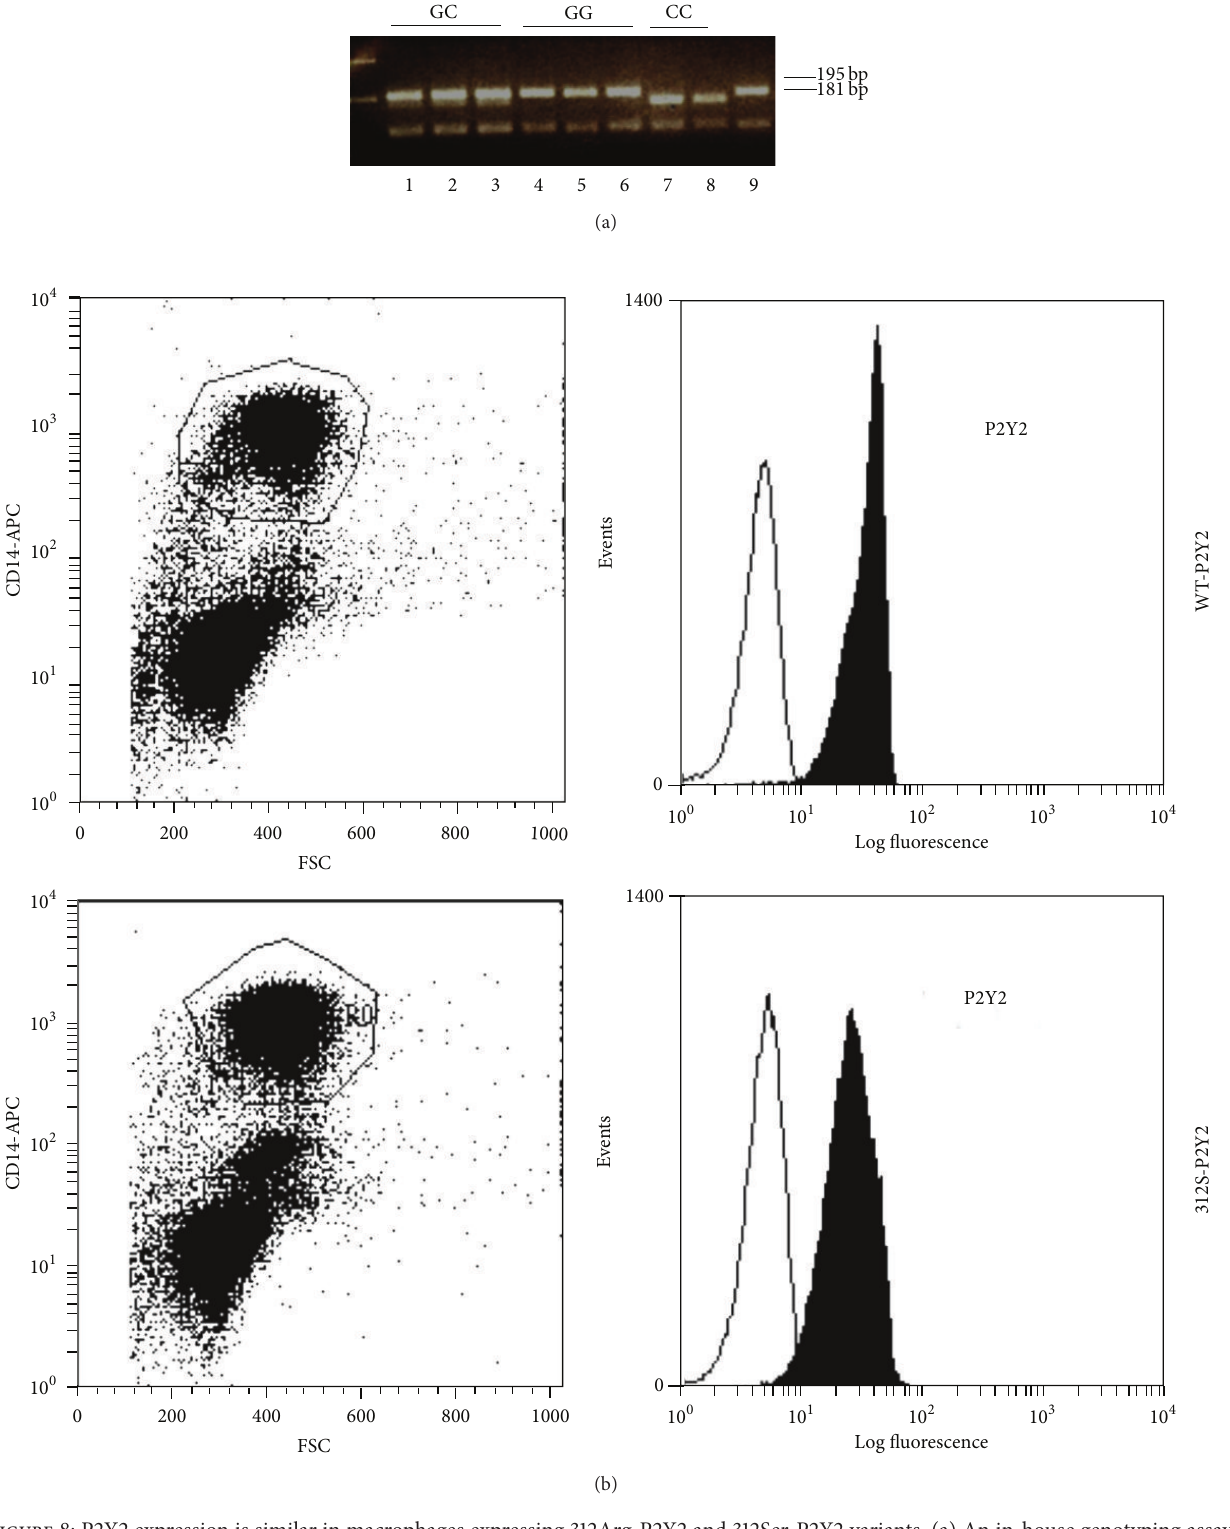
Figure 8: P2Y2 expression is similar in macrophages expressing 312Arg-P2Y2 and 312Ser-P2Y2 variants. (a) An in-house genotyping assay was designed using PCR and restriction enzyme analysis with MwoI. Individuals with GG (wild-type, lanes 4, 5, and 6) have a single upper band of 195bp. Individuals with CC (homozygous for 312Ser, lanes 7 and 8) show a single upper band of 181bp. Individuals with GC genotype (heterozygous for 312Ser, lanes 1, 2, and 3) show two upper bands at 195 and 181bp. (b) Flow cytometry dot plots showing gating of CD14 positive PBMCs and representative histograms showing P2Y2 expression on CD14 + gated